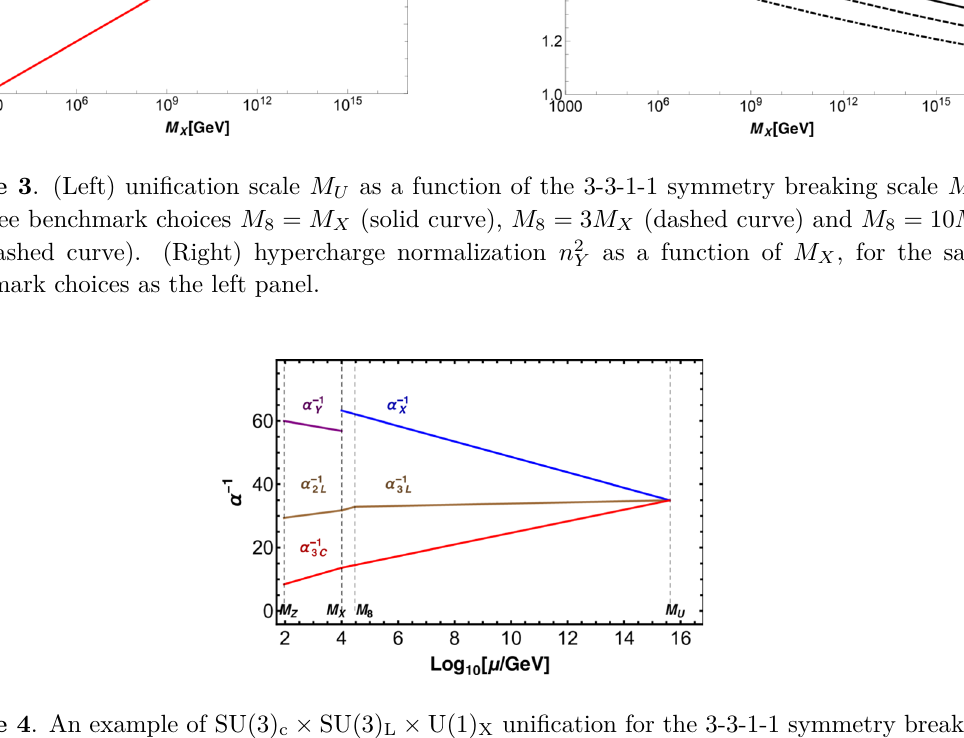
Figure 4 . An example of SU(3) c × SU(3) L × U(1) X unification for the 3-3-1-1 symmetry breaking scale M = 10 TeV and M = 3 M = 30 TeV, corresponding to the dashed curves in figure 3. X 8 X